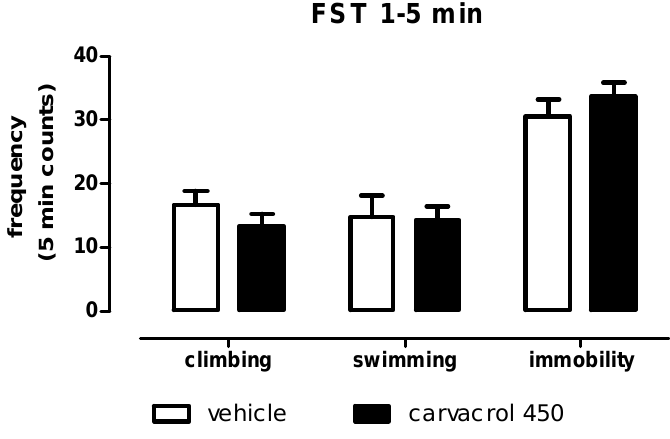
Figure 3. Measures of climbing, swimming and immobility frequencies during FST in male Wistar rats after carvacrol (450 mg/kg, p.o.) or vehicle (peanut oil, 1 mL/kg, p.o.) administration. Data were expressed as mean + SEM ( n = 10, unpaired student’s t-test,